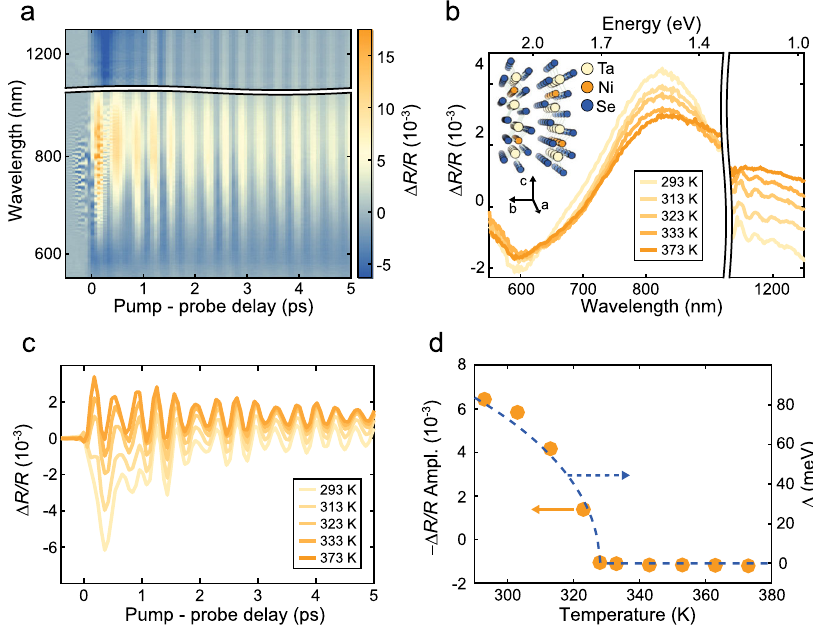
Fig. 1 Temperature dependence of the transient re fl ectivity signal of Ta 2 NiSe 5 . a Δ R / R signal measured at room temperature as a function of pump- probe delay and probe wavelength for Φ pump = 50 µ J/cm 2 . b Spectra of Δ R / R averaged between 1 and 2 ps for a series of temperatures and Φ pump = 50 µ J/cm 2 . The range between 930 and 1130 nm is removed in panels ( a , b ) to eliminate the noise due to residual spectral components of the laser pulses used to generate the probe beam. c Δ R / R kinetic at 1200 nm corresponding to the data in panel ( b ). d Temperature dependence of the signal amplitude (orange dots, left y -axis) and of a BCS-like order parameter calculated using 37 Δ ð T Þ = Δ ð 0 Þ (cid:2) 1 : 74 ð 1 (cid:3) T = T axis). The amplitudes are extracted from a fi t of the incoherent component of the signal (see Supplementary Information Note 2 for more details). In the inset of panel ( b ) we show the crystal structure of TaNiSe ( fi gure generated with the software Vesta 68